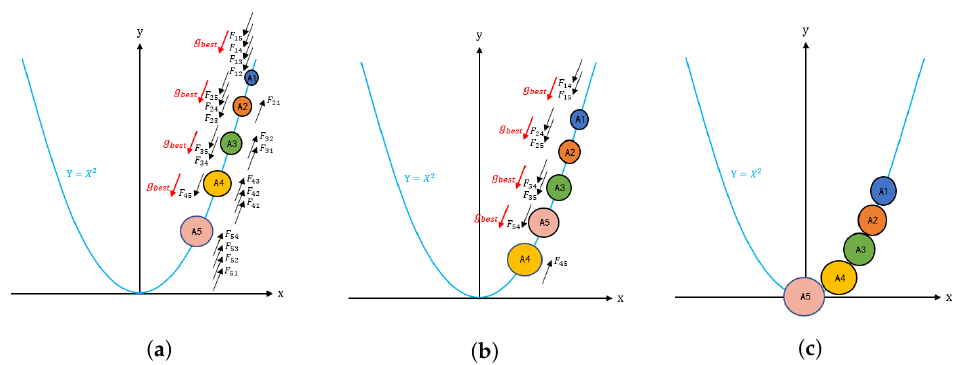
Figure 3. Movement behavior of agents after using the gbest and elite agents: ( a ) movement behavior of agents when kbest = 5; ( b ) movement behavior of agents when kbest ≤ 2; ( c ) result of movement